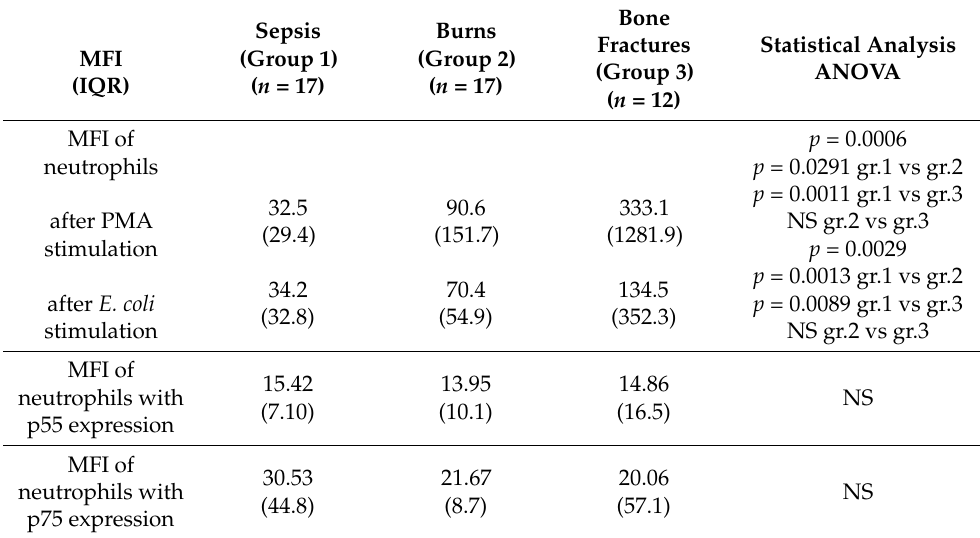
Table 3. Fluorescence intensity of the neutrophils (at the time of sepsis diagnosis or within the first 6–24 h after injury diagnosis) in the studied groups of children with